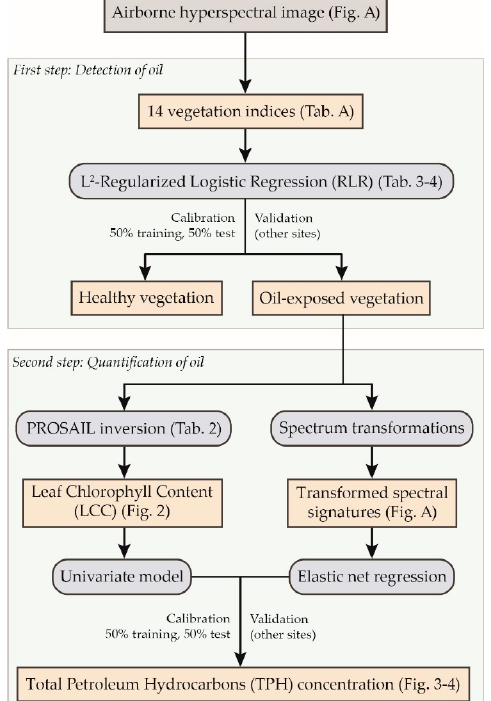
Figure A2. Flowchart of the approach proposed in this study. The method of oil detection was developed and tested at leaf and canopy scales in [28], so it was only evaluated on the airborne image in this study. The two methods of total petroleum hydrocarbons (TPH) quantification were tested in the field at leaf and canopy scales and on the airborne image. All the methods were first calibrated on study sites and validated on additional sites (see Table 1 for details about the